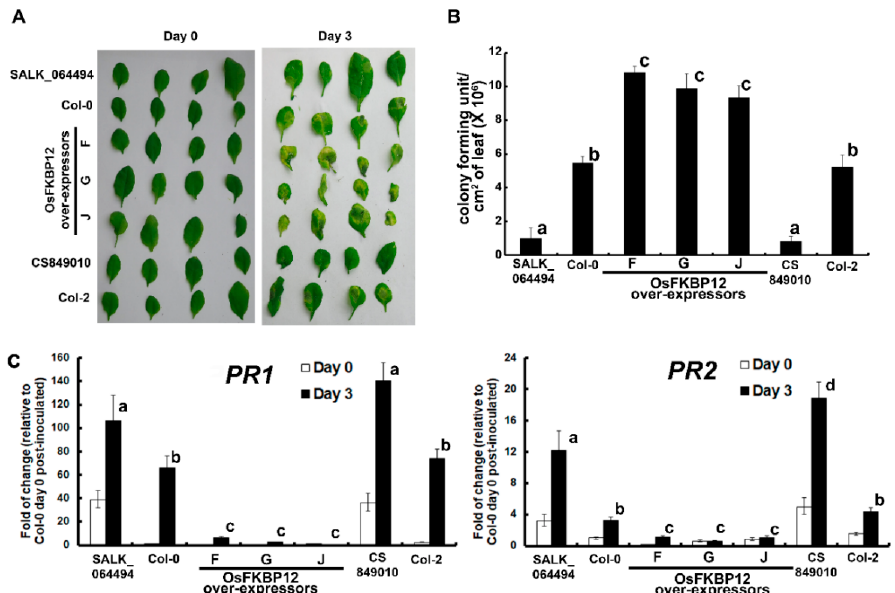
Figure 3. Pathogen inoculation of OsFKBP12 -transgenic A. thaliana . Three independent transgenic Arabidopsis lines (F, G and J) ectopically expressing OsFKBP12 , two AtFKBP12- knockout mutant lines of Arabidopsis (CS849010 and SALK_064494) and two wild-types (Col-0 and Col-2) were inoculated with the pathogen, Pseudomonas syringae pv. tomato ( Pst DC3000), at six weeks old by syringe infiltration at a concentration of 10 8 colony forming units/mL in 10 mM MgSO 4 supplemented with 0.02% ( v / v ) Silwet L-77 [27]. Leaves were harvested three days post-inoculation for ( A ) phenotypic analyses, ( B ) pathogen titer determination and ( C ) relative gene expression analyses of two defense marker genes, PR1 and PR2 . The pathogen titers (colony-forming units per unit area) at the inoculation zones (harvested as leaf discs) were estimated by plate count method [27]. Relative gene expressions were calculated using the 2 − ∆∆ CT method, with UBQ10 as the normalizing gene [28,29]. For fold-of-change calculations, the expression levels of PR1 and PR2 in Col-0 on day 0 were set to 1 as reference. Statistical significance was analyzed using one-way analysis of variance combined with the Games–Howell post hoc test. Error bars represent standard errors. Di ff erent lowercase letters above the bars represent statistically distinct groups at p < 0.05. Two biological repeats with similar results were